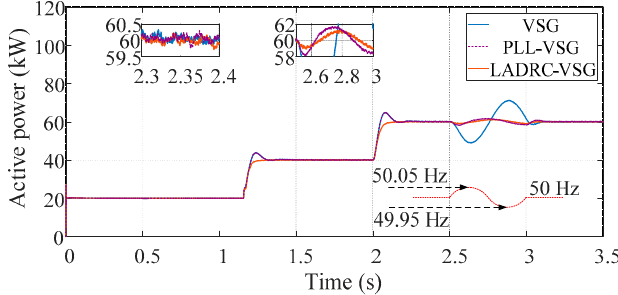
Figure 22. Output power of VSG under different control strategies.